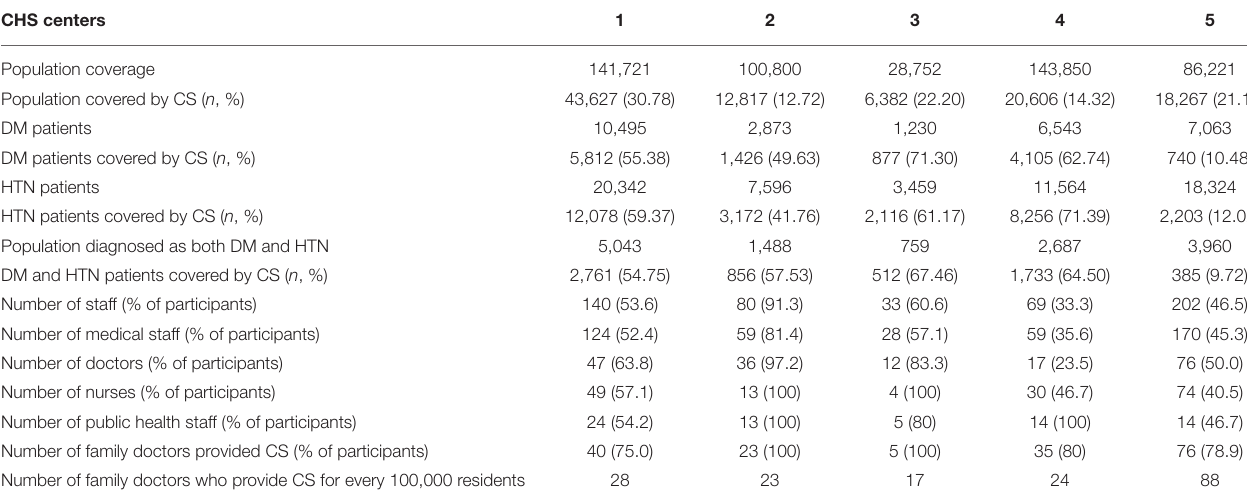
TABLE 1 | Basic characteristics of the five selected CHS centers from three provinces in China, 2016. CHS